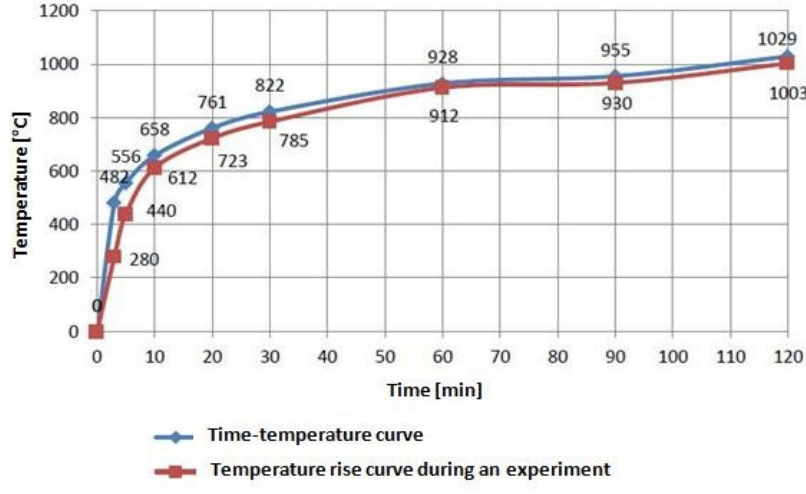
Figure 7. Curve showing the temperature increase in the furnace during the test.